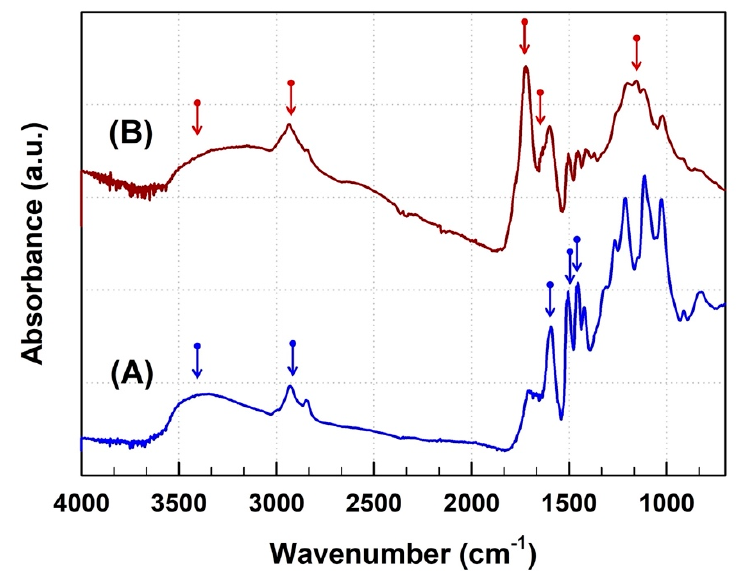
Figure 1. FT-IR spectra of pristine lignin ( A ) and COOH-lignin ( B ). The effect of the presence of pristine lignin and COOH-lignin on the thermal behavior of the PLA matrix was studied using DSC. Table 1 presents thermal characteristics of the melting temperature ( T m ) observed from the second heating cycle and glass transition tem- perature ( T g ) for pristine lignin- or COOH-lignin-reinforced PLA biocomposites. On the basis of Table 1, compatibility between the PLA matrix and lignin domain in the biocompos- ites should be inferred. The presence of lignin in the PLA matrix did not significantly affect the melting-point depression phenomenon, which decreased from 152.2 to 149.2 ◦ C with increasing content of pristine lignin, consistent with the behavior of lignin as a filler and not a nucleating agent for all the studied PLA-based biocomposites. On the DSC thermograms, the glass transition temperatures of COOH-lignin-reinforced PLA biocomposites showed similar trends to that of pristine lignin-reinforced PLA biocomposites, ranging from 60.3 to 63.4 ◦ C. Further, the sharp T g transition occurred in all biocomposites. Sometimes, a broad T g transition in a polymer composite system is caused by the complex molecular structure that leads to multiple relaxation phases within the same transition temperature range [38]. Therefore, even the lignin was chemically modified by maleic anhydride on its surface, though it did not significantly affect the thermal characteristics of the PLA matrix in the Table 1. The melting temperatures ( T m ) and glass transition temperatures ( T g ) of poly(lactic acid) (PLA)-based biocomposites with pristine lignin and COOH-lignin content. Pristine Lignin COOH-Lignin Lignin Content (wt.%) T m ( o C) T g ( o C) T m ( o C) T g ( o C) 5 152.2 63.4 152.1 64.4 10 150.1 60.6 152.5 63.9 15 151.7 62.5 151.5 63.4 20 149.2 60.3 152.2 65.0